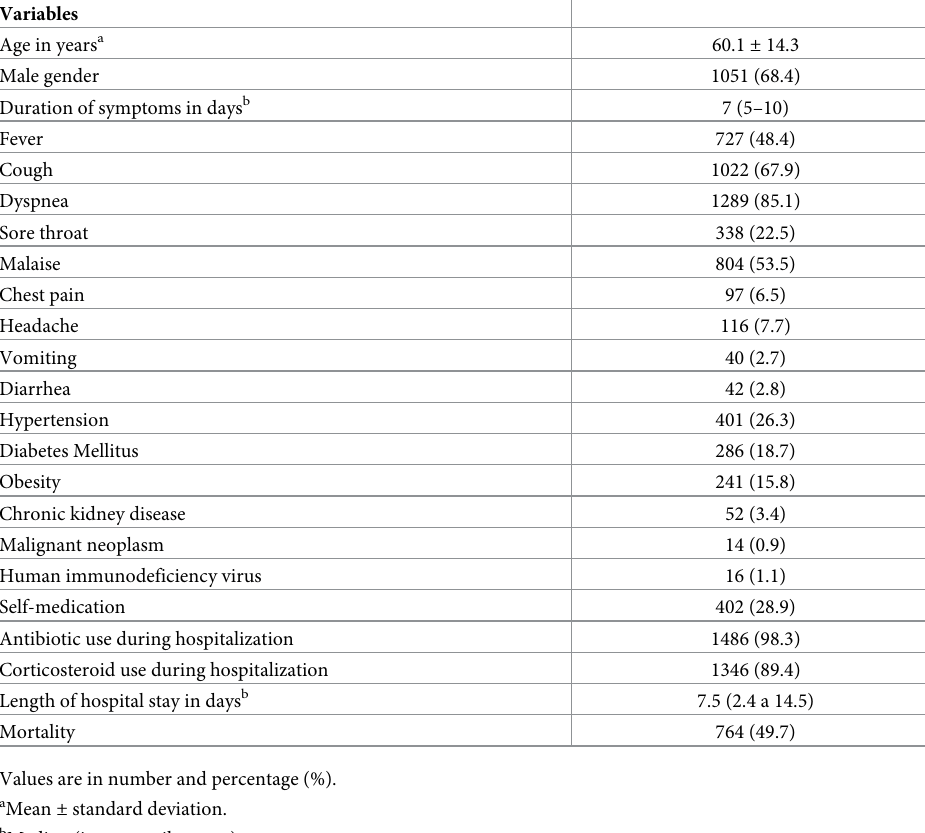
Table 1. Characteristics of hospitalized patients with SARS-CoV-2